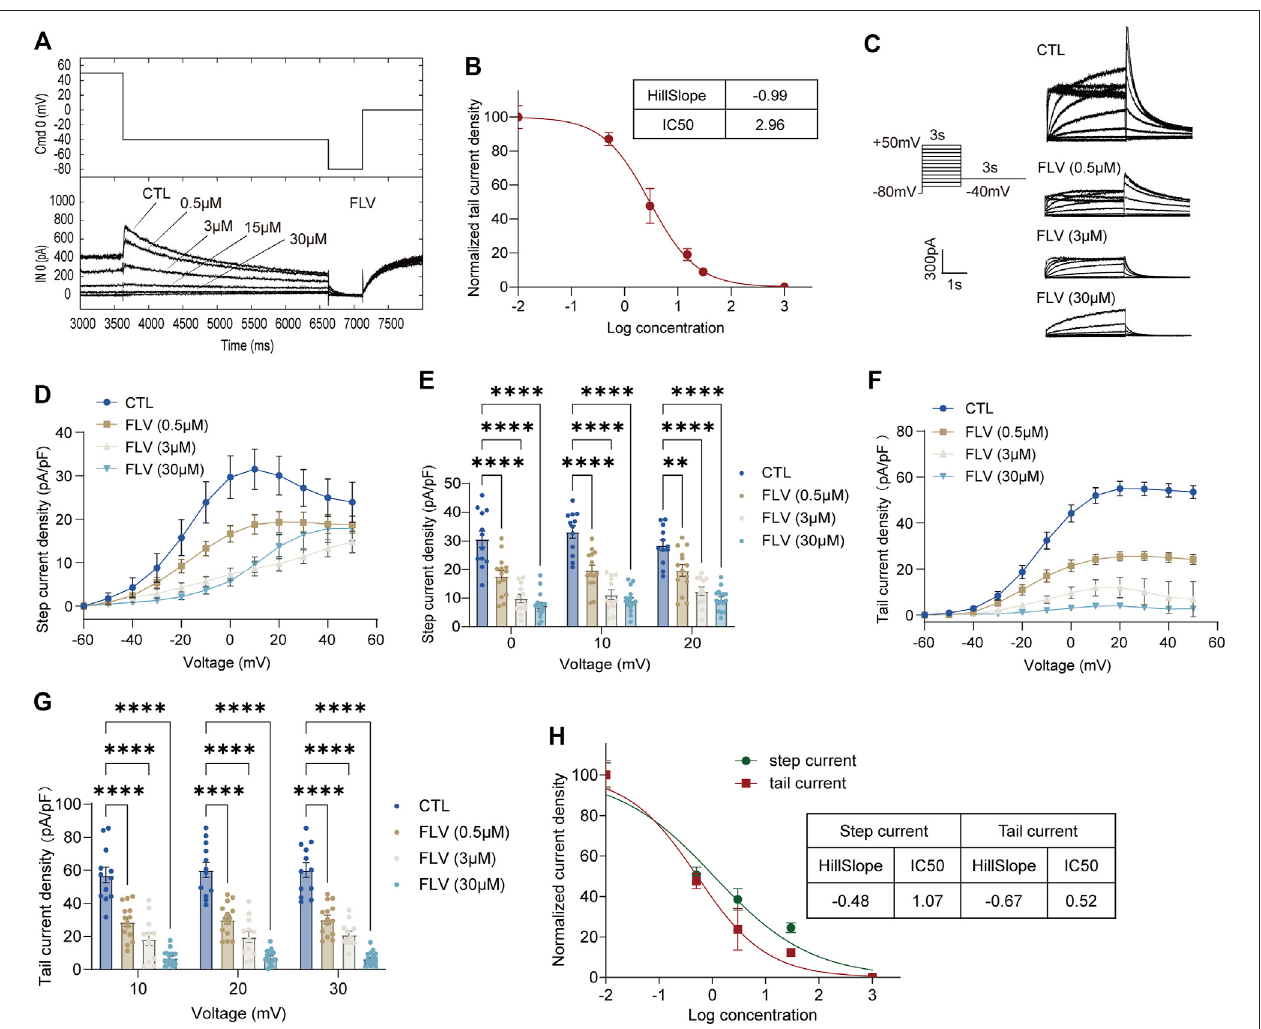
FIGURE 1 | Inhibition of the hERG currents by fl uvoxamine (FLV). (A) Concentration-dependent acute inhibition of hERG tail currents elicited by the protocol is shown. (B) Normalized data of tail current density at + 50 mV were fi tted with the Hill equation to yield a concentration for half-maximal inhibition (IC50) and a Hill coef fi cient, n = 5. (C) Representative I hERG recorded in control (CTL) and after drug application for 24 h with the voltage protocol. (D) Original data using the membrane capacitance (pF) of each cell to calculate the step current density (pA/pF) to form the current I – V curve of the hERG channel. (E) Bar chart showing statistical step current at 0 mV to + 20 mV in CTL or FLV with different concentrations. (F) I – V curve of the tail current density (pA/pF). (G) Statistical tail current density at + 10 mV to + 30 mV, n =12 – 16.** p < 0.01and**** p < 0.0001. (H) Normalizeddataonstep andtailcurrentdensity at +30 mVwere fi ttedwiththeHillequationyieldinganIC50 anda Hill coef fi